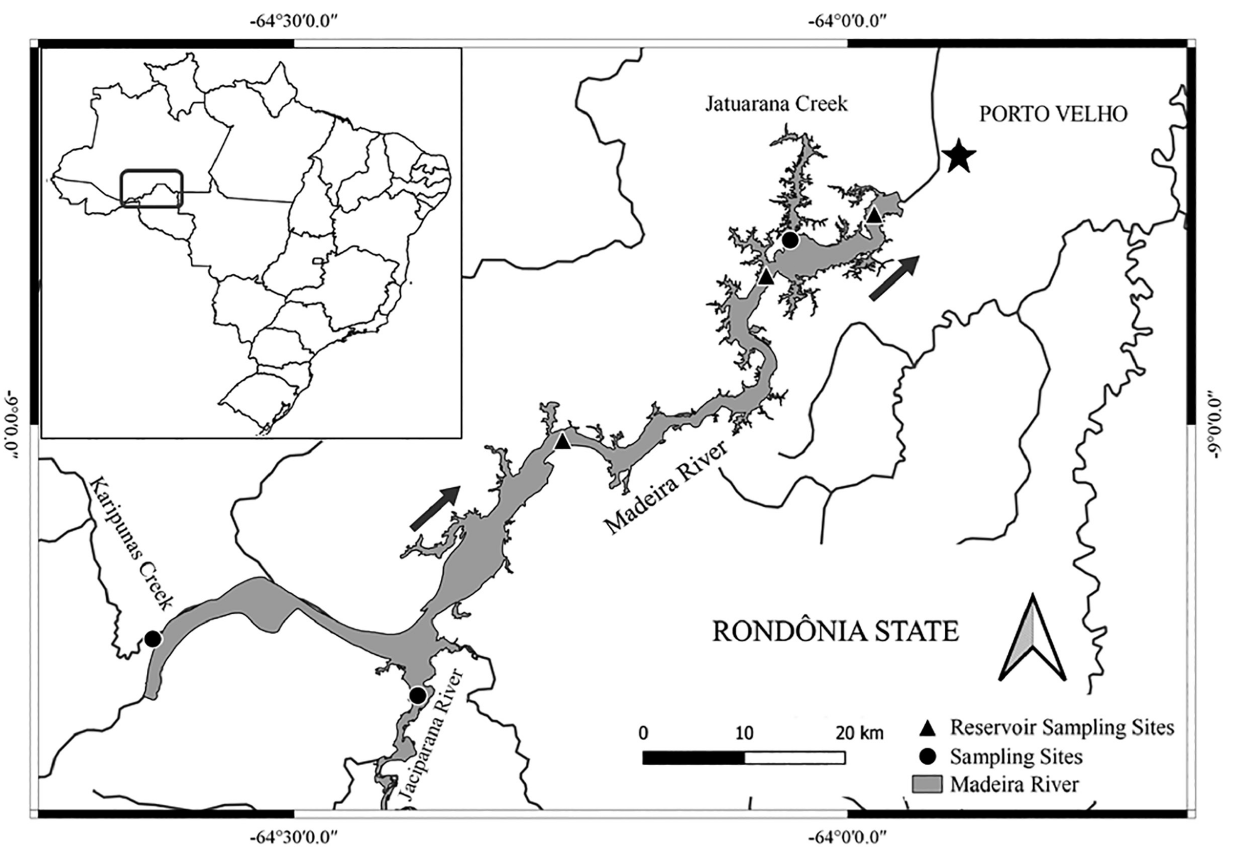
FIGURE 1 | Study area in the Madeira River portion. Black points representing fixed sampling sites for both pre-and post-damming phases. Triangles represent the sampling sites located in the reservoir area in the post-damming phase. Arrows indicate the river